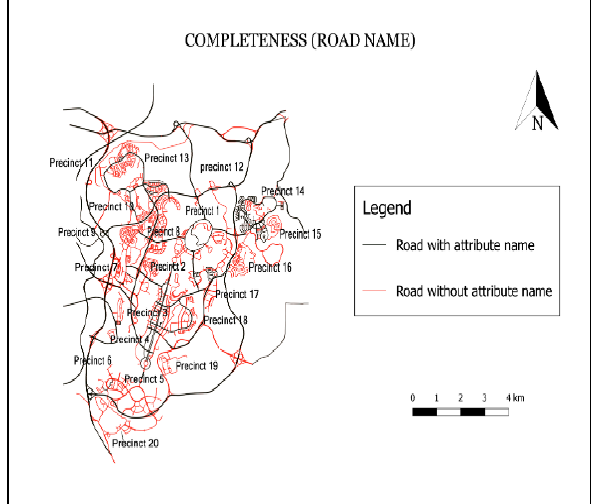
Figure 5: Completeness of road